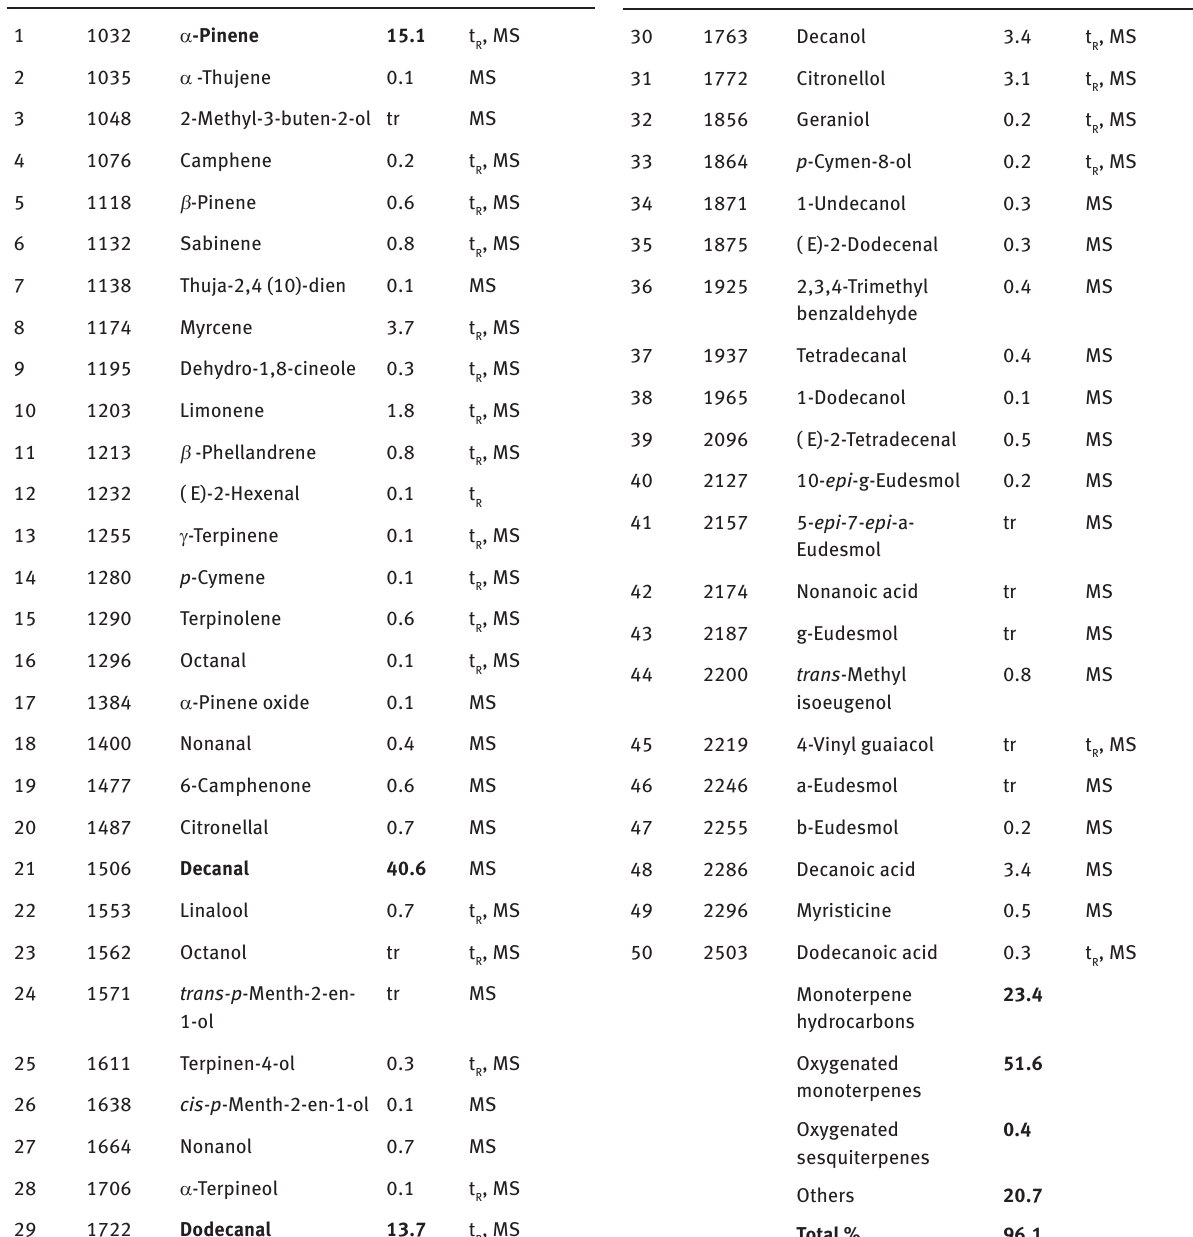
Table 1: Chemical content of the essential oil of Ducrosia ismaelis . No. RRI Compounds